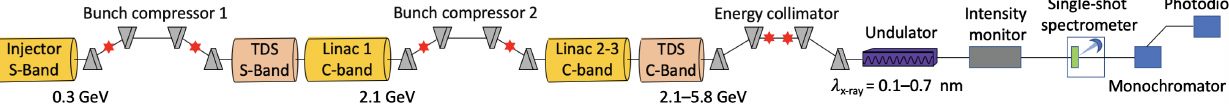
2. SwissFEL schematic (not to scale). Six sextupole magnets (marked in red) placed in the dispersive sections are available for our two-color scheme. Two transverse-deflecting cavities (TDS) can streak the electron beam in the vertical direction for longitudinal